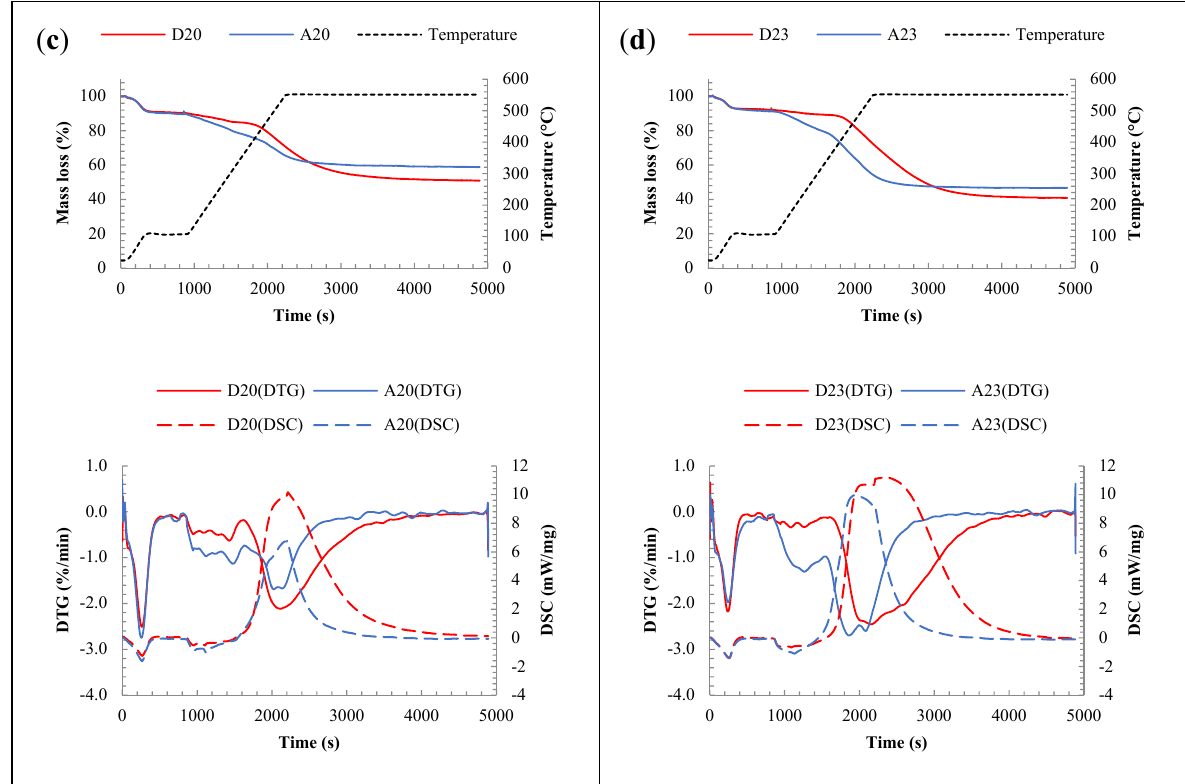
Figure 4. TG, DTG and DSC curves of deposited (D) and adhered (A) fouling samples obtained with the following combustion parameters: 3 h of stable combustion, a distribution of 25% and 75% of primary and secondary airflow and a deposition probe temperature kept in the range of 20–25 °C. The number indicates the total airflow of ( a ) 14 m 3 /h, ( b ) 17 m 3 /h, ( c ) 20 m 3 /h and ( d ) 23 m 3 /h. Combustion performed with 11 m 3 /h and 25 m 3 /h of airflow were not